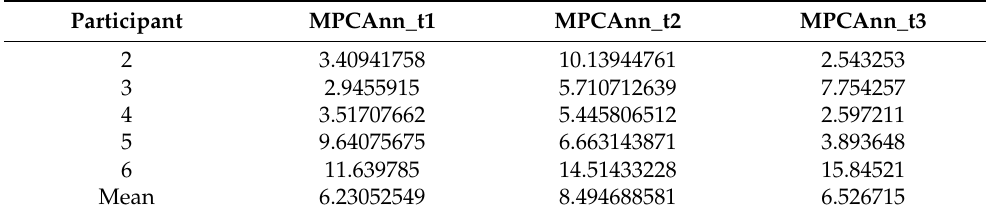
Table 22. MPCAn, nectar 10 mL (% C2–42) individual and mean measurements at three assessment time points.